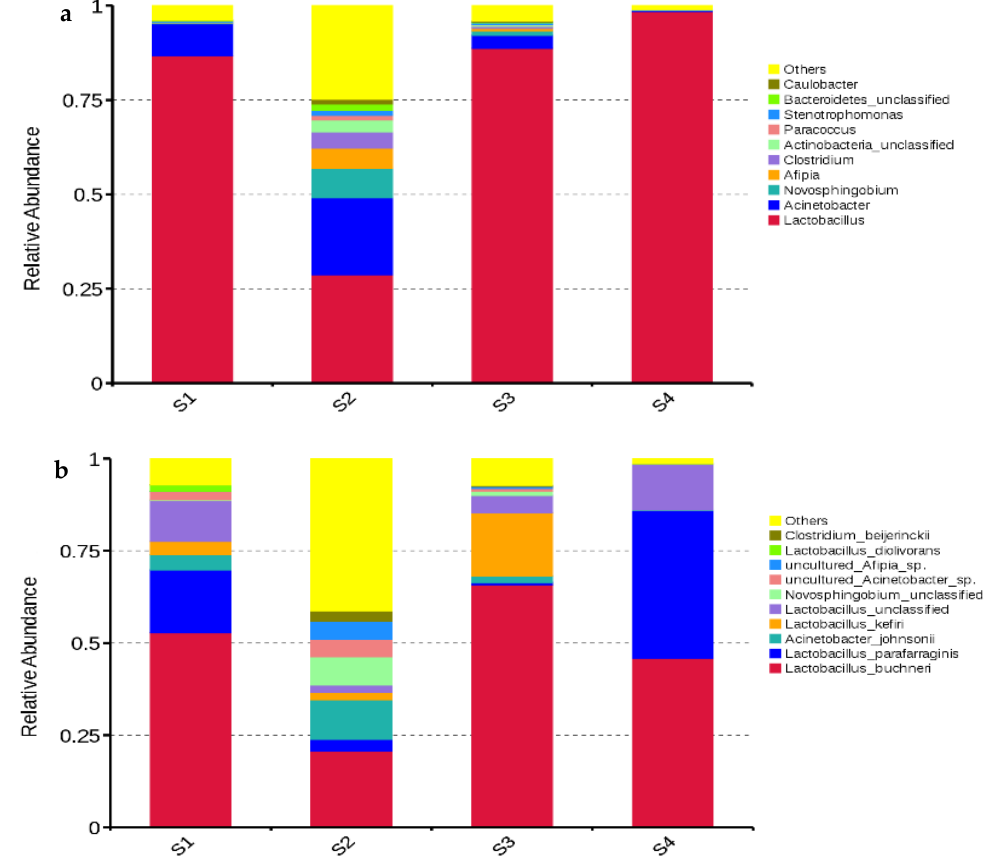
Figure 3. Relative abundances of bacterial genera ( a ) and species ( b ) in whole-plant corn silage (n = 3). S1, silage collected frm Erdos; S2, silage collected from Baotou; S3, silage collected from Ulanqab; S4, silage collected from Hohhot.